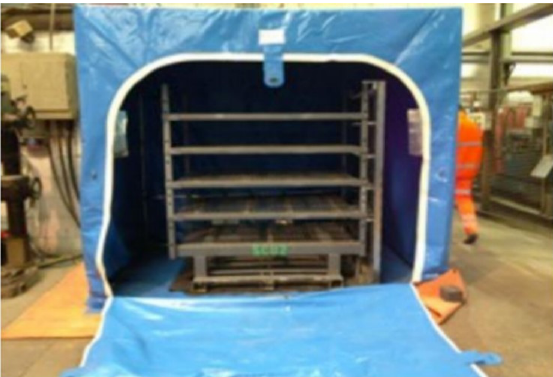
Figure 3. Solidia test chamber. Source: [33].